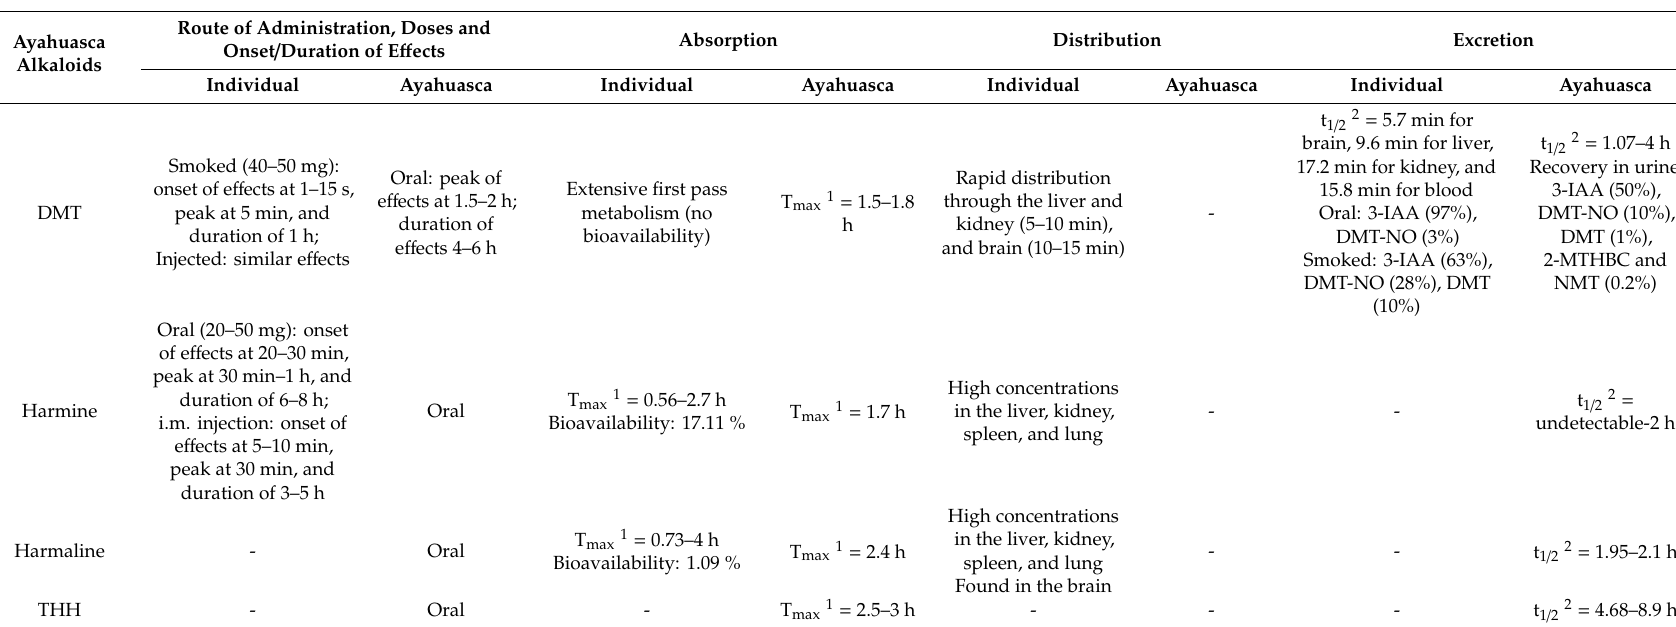
Pharmacokinetics of N , N -dimethyltryptamine (DMT), harmine, harmaline, and tetrahydroharmine (THH), when administered alone or in ayahuasca